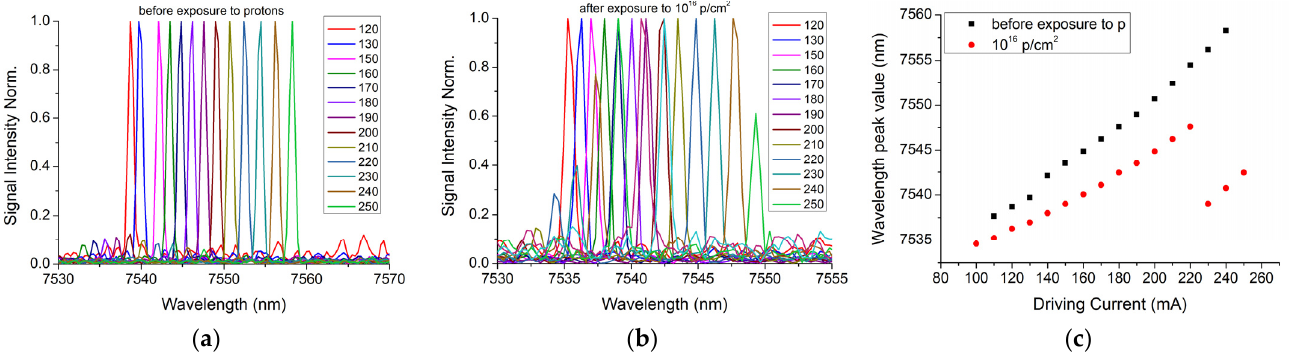
Figure 5. QCL tuning capabilities with the driving current variation for a case temperature of 10 °C ( a ) before irradiation, ( b ) after exposure to 10 16 p/cm 2 ; ( c ) the peak wavelength dependence on the driving current.